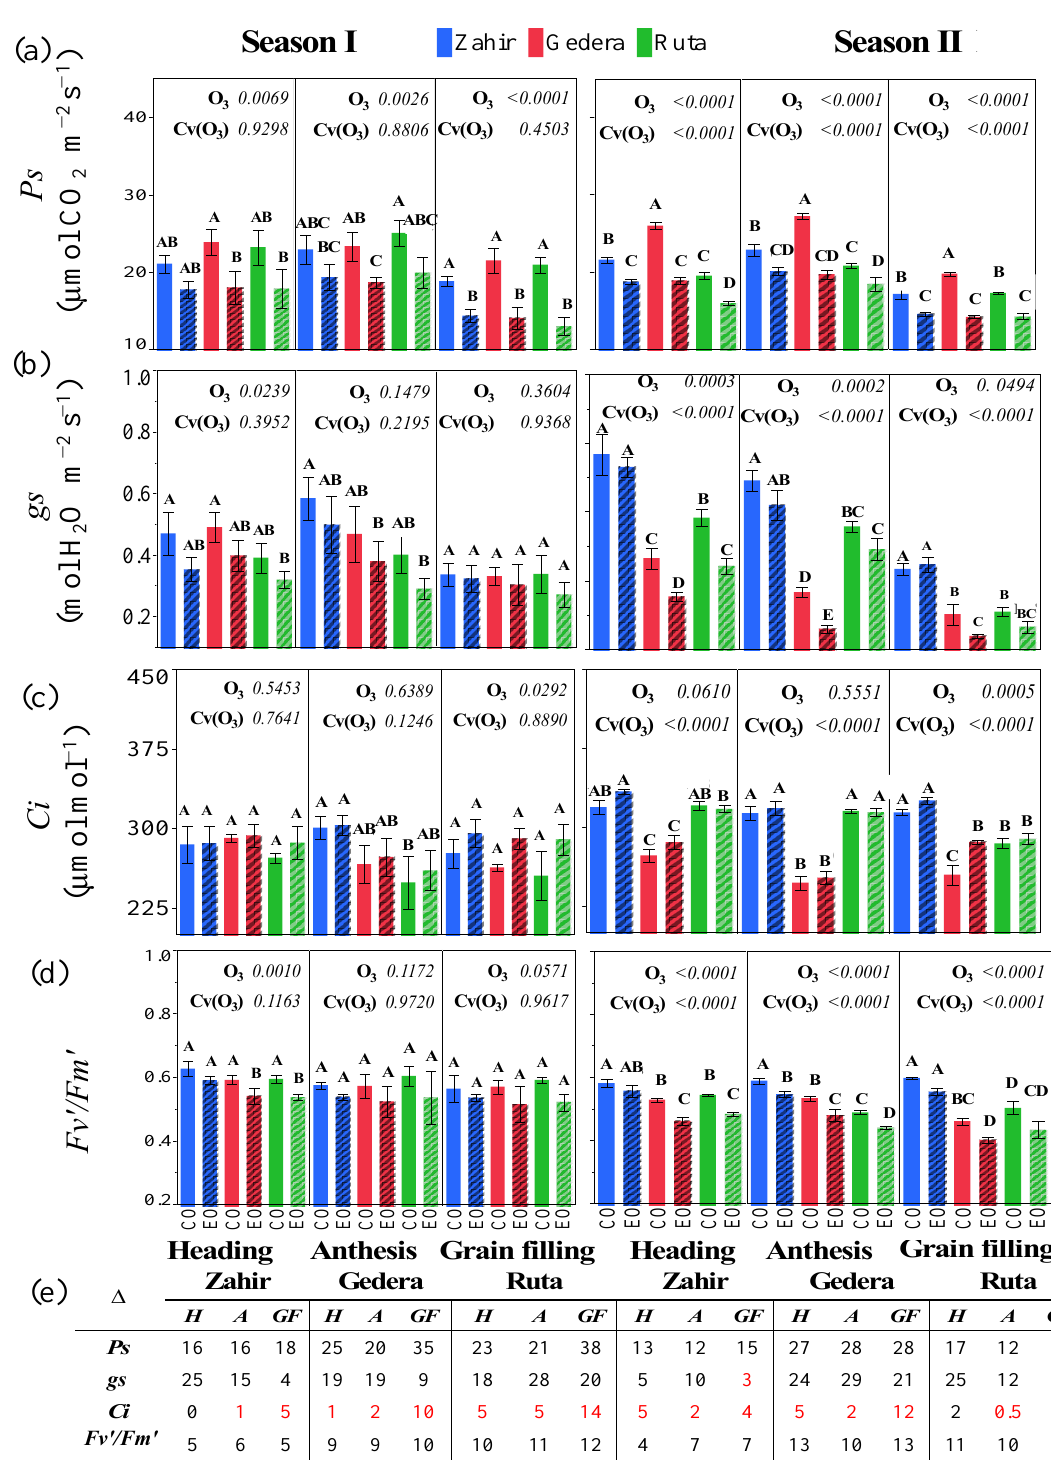
Figure 7. OTC experiment. ( a – d ) Physiological parameters of cultivars at heading (H), anthesis (A), and grain filling (GF) phenological stages in OTC enriched with O 3 (EO) and the corresponding control (CO) (mean ± SE, n = 5). Different letters above the bars indicate significant differences ( p < 0.05) according to Student’s t -test. ( e ) Table showing percentage change (reduced values are in black and increased values are in red) in the physiological parameters between CO and EO during season I and season II. p -values of factors O 3 exposure (O 3 ) and cultivar within O 3 effect Cv(O 3 ) for physiological parameters by ANOVA are also shown.